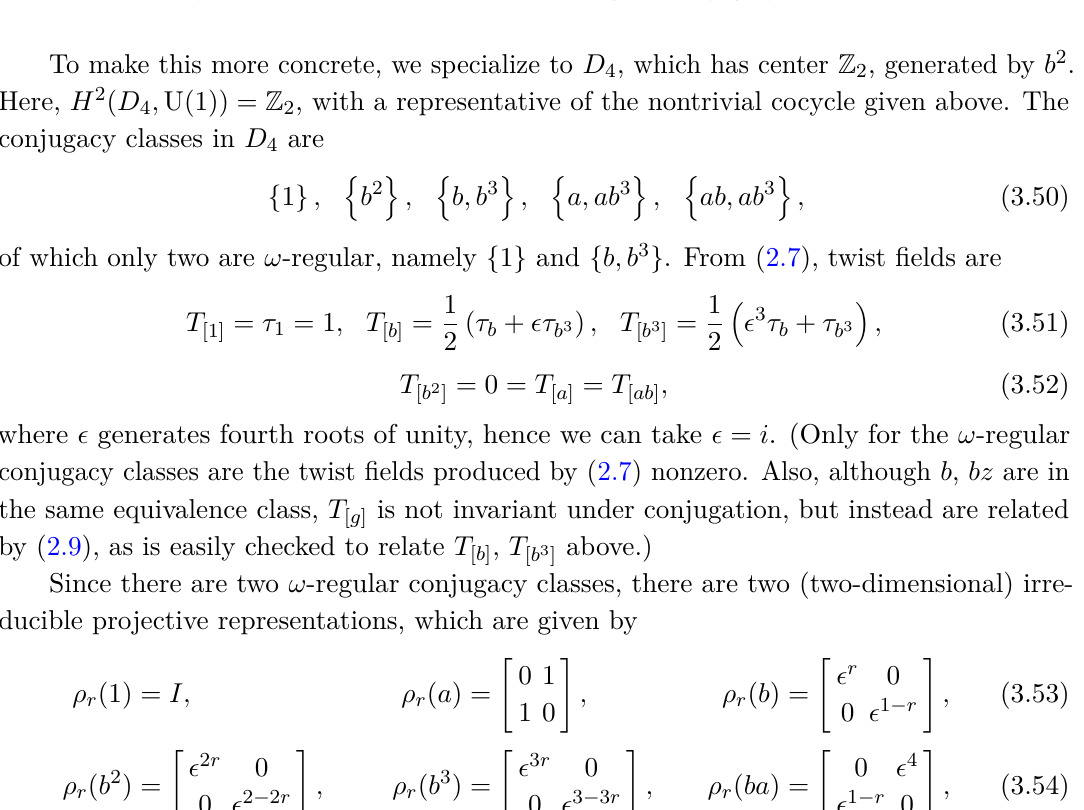
Table 5 . Character table for irreducible projective representations of D 4 . Note that although b and b 3 are in the same conjugacy class of D 4 , their characters are different, so we list them separately. Also note that only characters of representatives of ω -regular conjugacy classes are